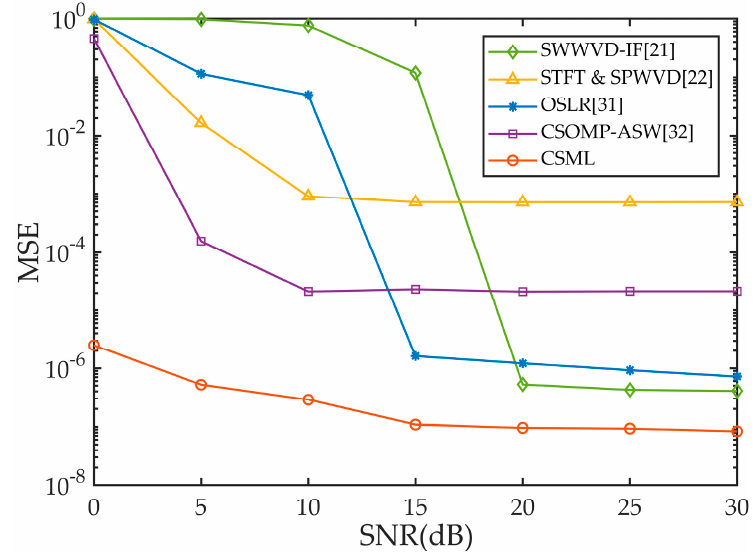
Figure 13. The MSE of five algorithms for the estimation of hopping time. Figure 13 and Table 4 show the MSEs of the hopping-time estimation of the